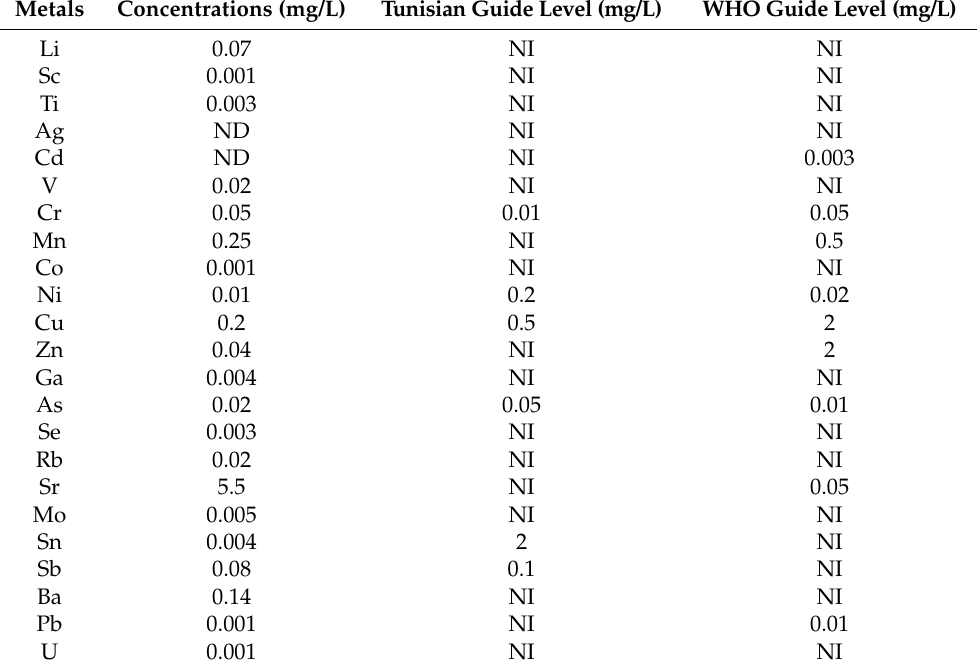
Table 1. Concentrations of metals analyzed in the TDE sample and national and international permissible standards.